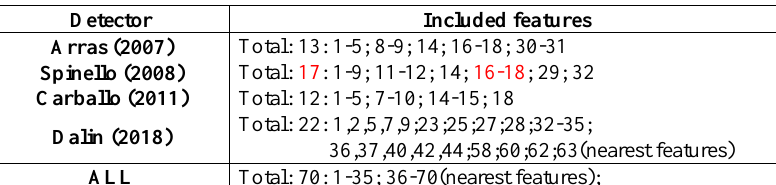
Table 5. The state-of-the-art